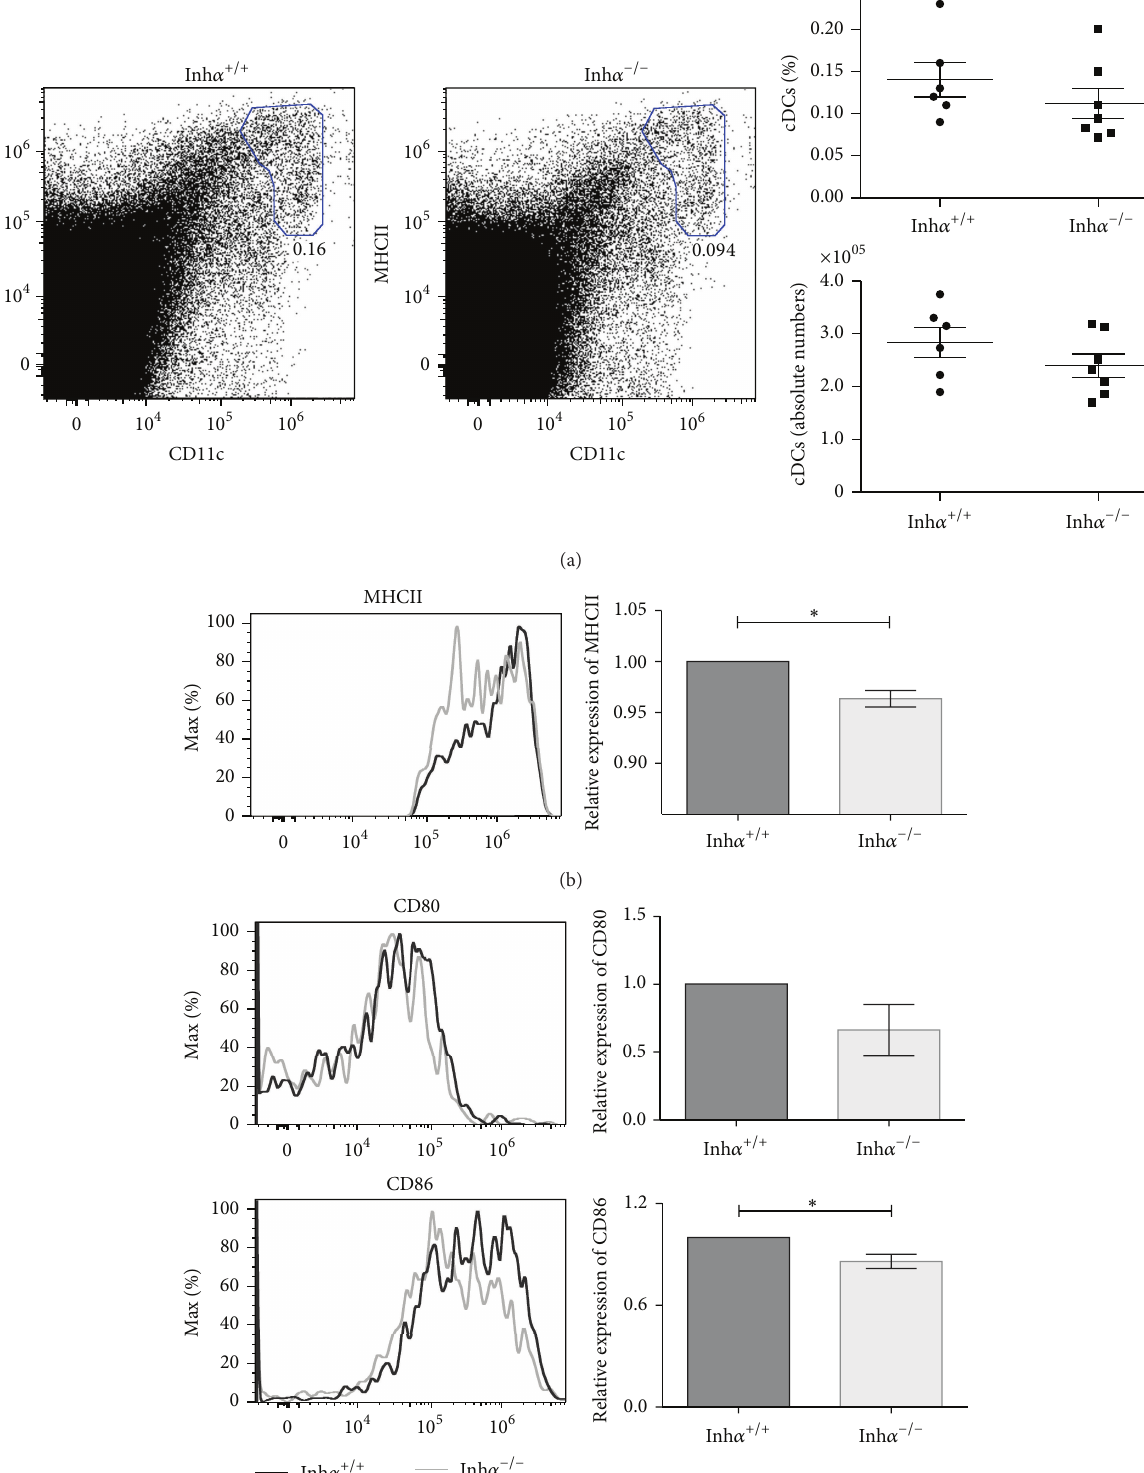
Figure 2: MHCII and CD86 expression in cDCs are reduced in thymus of Inh 𝛼 −/− mice. (a) Representative flow cytometry dot plots and frequency of thymic cDCs defined as CD11c + MHCII + cells. For the MHCII (b), CD80 (c), and CD86 (c) expression, MFI was determined and reported as relative expression compared to Inh 𝛼 +/+ mice. A significant reduction was observed for MHCII ( 𝑃 = 0.04 ) and CD86 ( 𝑃 = 0.04 ) expression in Inh 𝛼 −/− thymic cDCs. One representative example of a total of 13 mice is shown (Inh 𝛼 +/+ , 𝑛 = 6 ; Inh 𝛼 −/− , 𝑛 = 7 ) from 3 independent experiments. Values are expressed as mean ± SEM. Statistical significance: ∗ 𝑃 ≤ 0.05